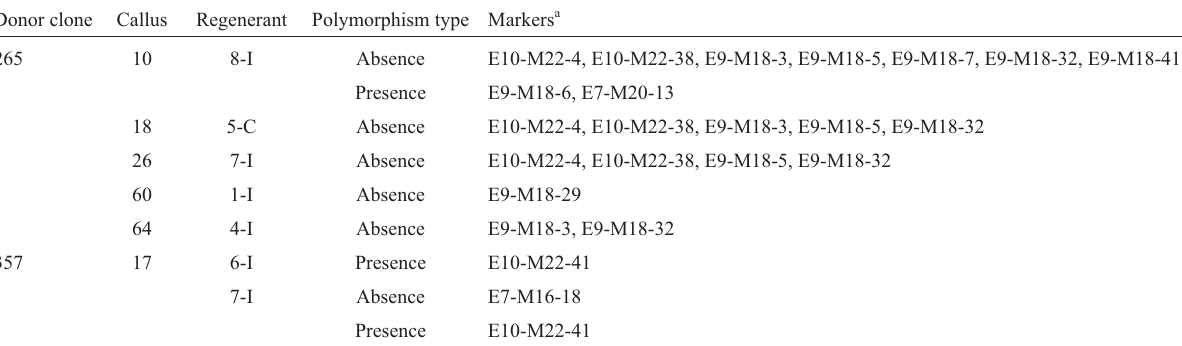
Table4 -Amplifiedfragmentlengthpolymorphism(AFLP)markerspolymorphicamongregenerantsandtheirrespectivedonorclones(265and357). Donor clone